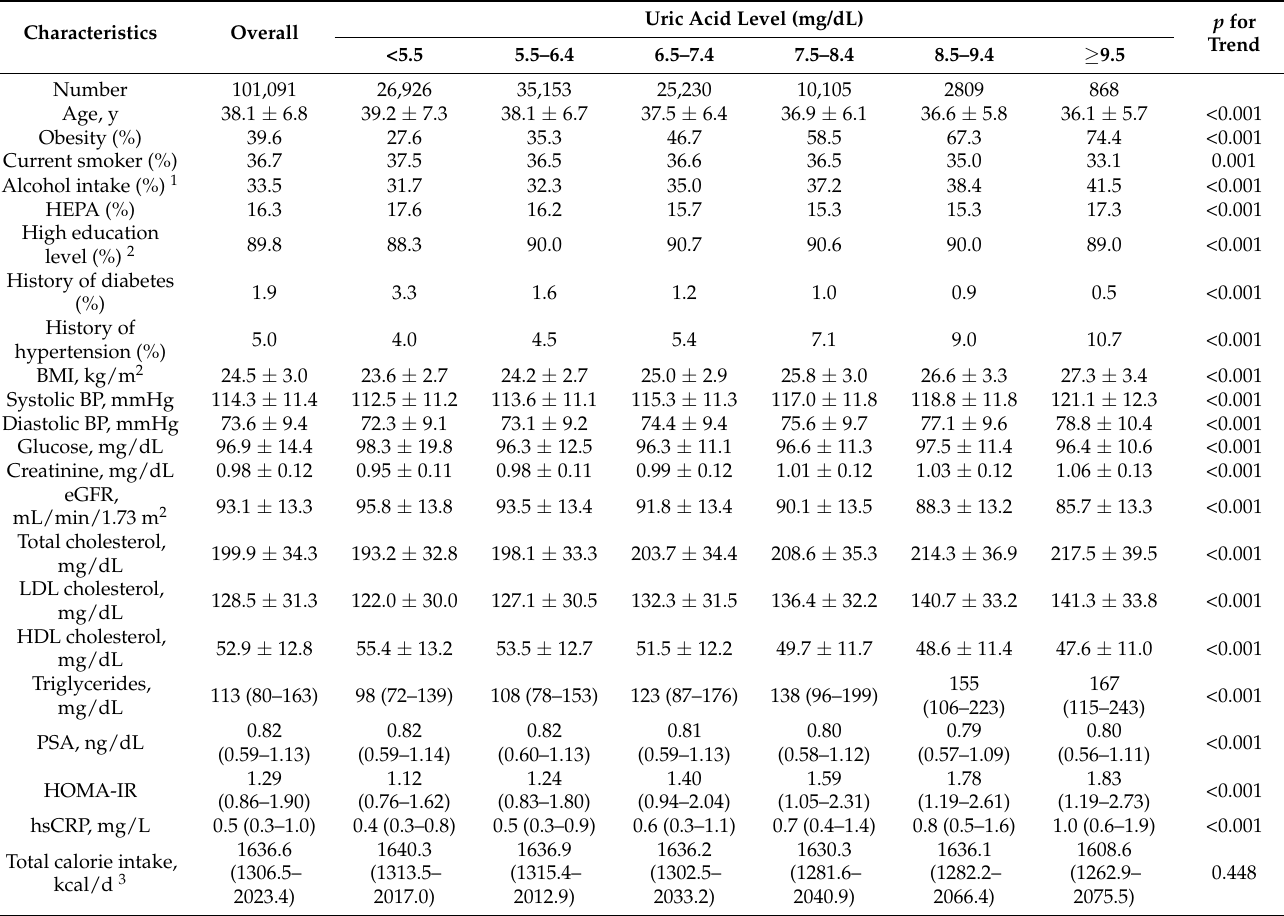
Table 1. Baseline characteristics by uric acid level.